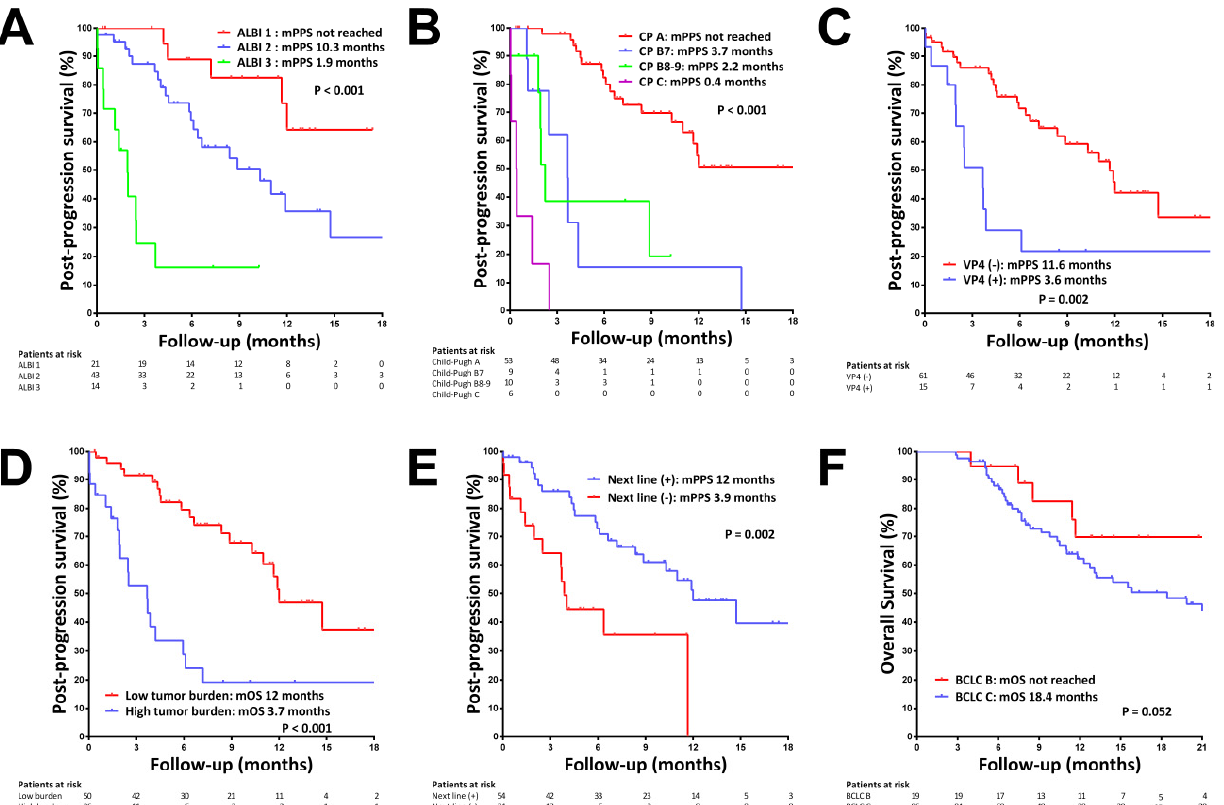
Figure 3. Kaplan–Meier curves for post-progression survival (PPS) after regorafenib failure and overall survival (OS) from starting sorafenib treatment. ( A ) PPS stratified by ALBI grade at disease progression. ( B ) PPS stratified by Child–Pugh class at disease progression. ( C ) PPS in patients with and without Vp4 vascular invasion. ( D ) PPS in patients with and without high tumor burden at disease progression. ( E ) PPS in patients who did and did not receive next-line therapy. ( F ) OS from starting sorafenib treatment stratified by BCLC stage.